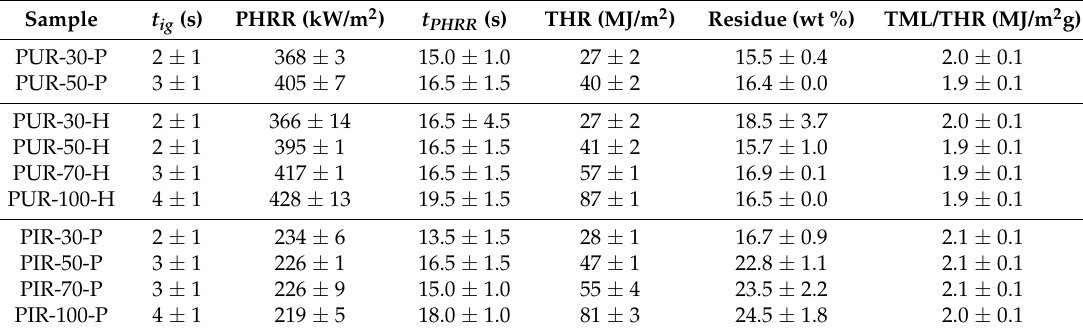
Table 6. Results of cone calorimeter